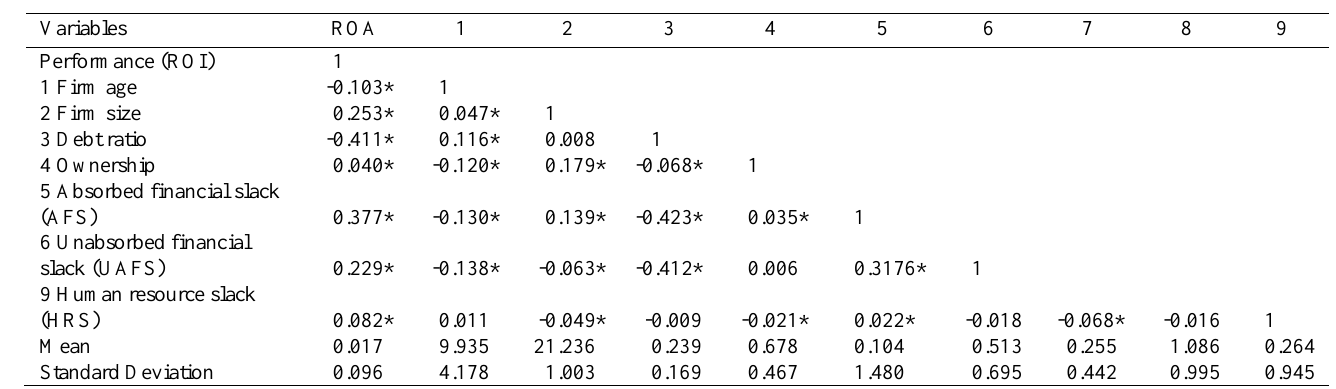
Table 1: Descriptive statistics and correlation matrix